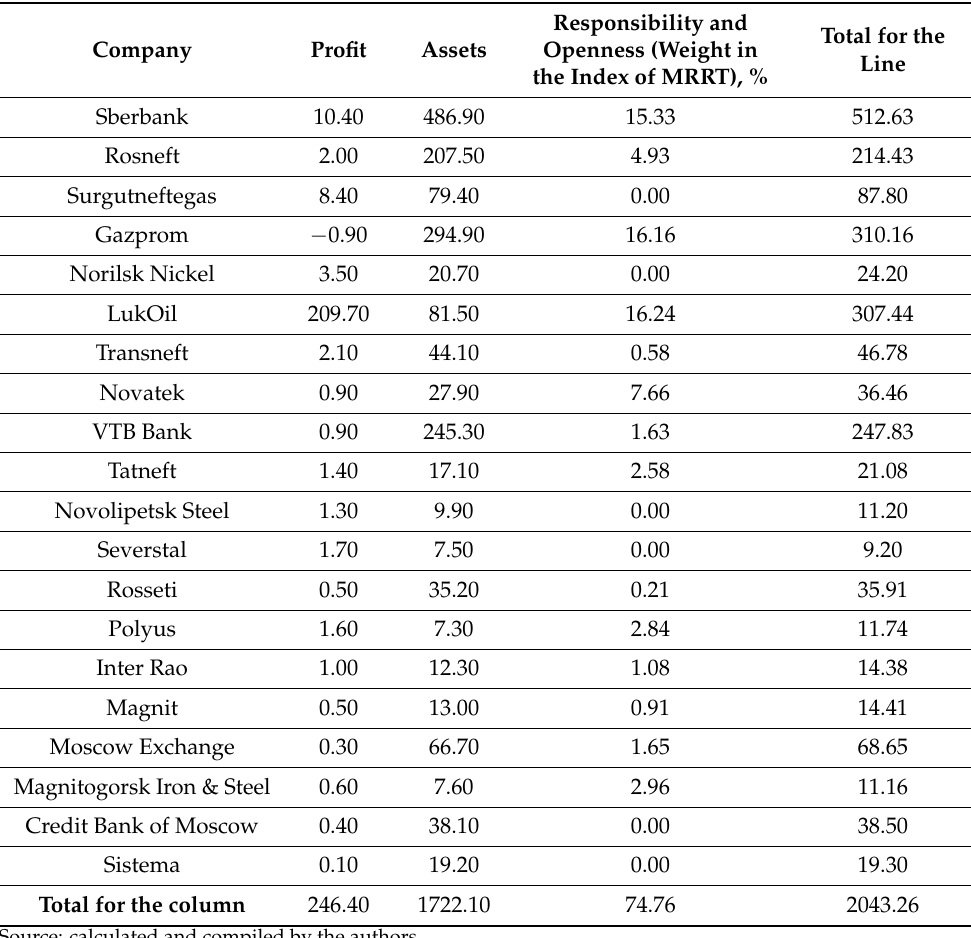
Table A4. Observed values of three variables in 2021.